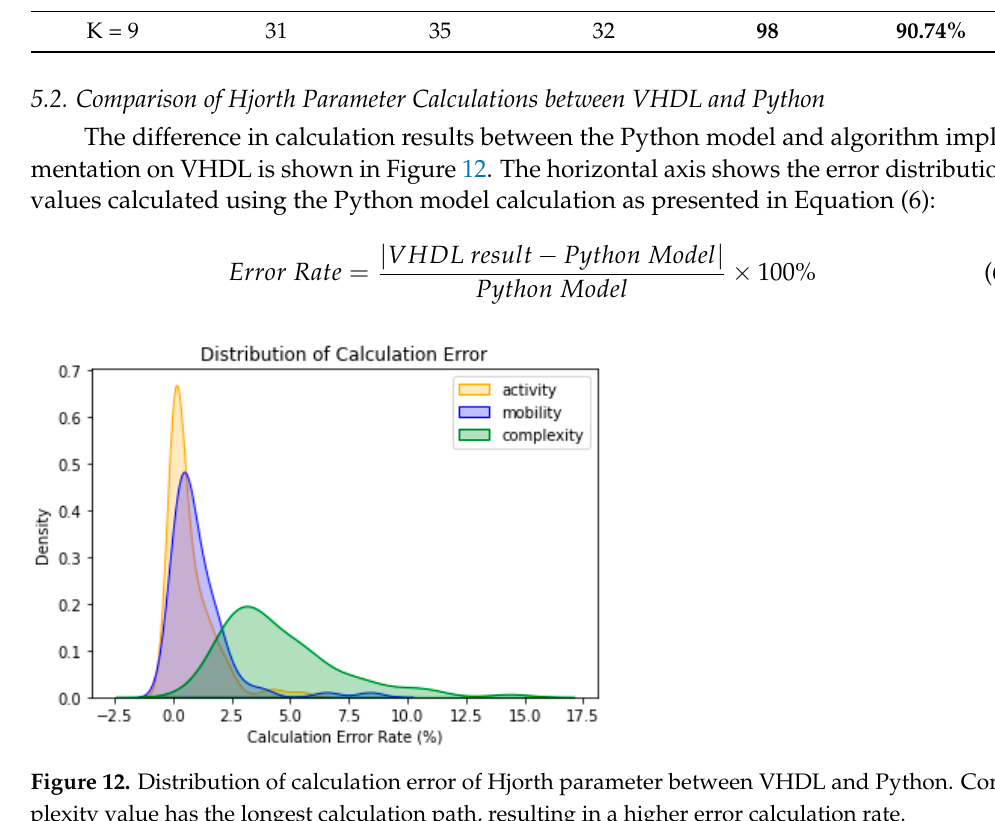
Figure 11 . Distribution of each feature calculation result shows the different characteristics from each EEG signal class.